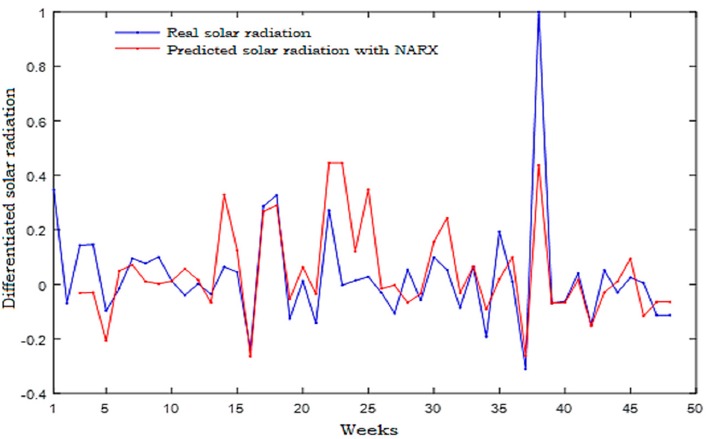
Figure 31. Prediction of solar radiation using the NARX model.